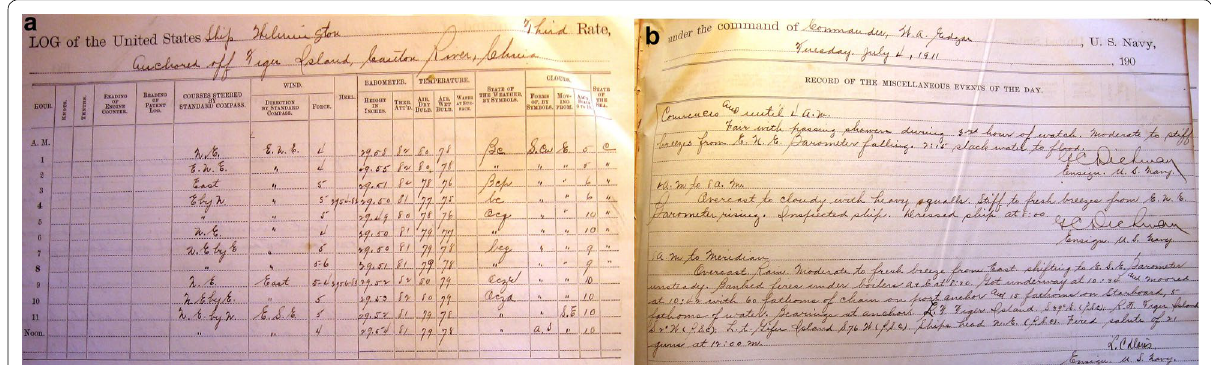
Fig. 1 Deck Log, USS Wilmington 1 July 1911, RG 24, US National Archives, Washington DC. Source courtesy of Dr. Cary Mock, University of South Carolina. For more information on this source, see Mock